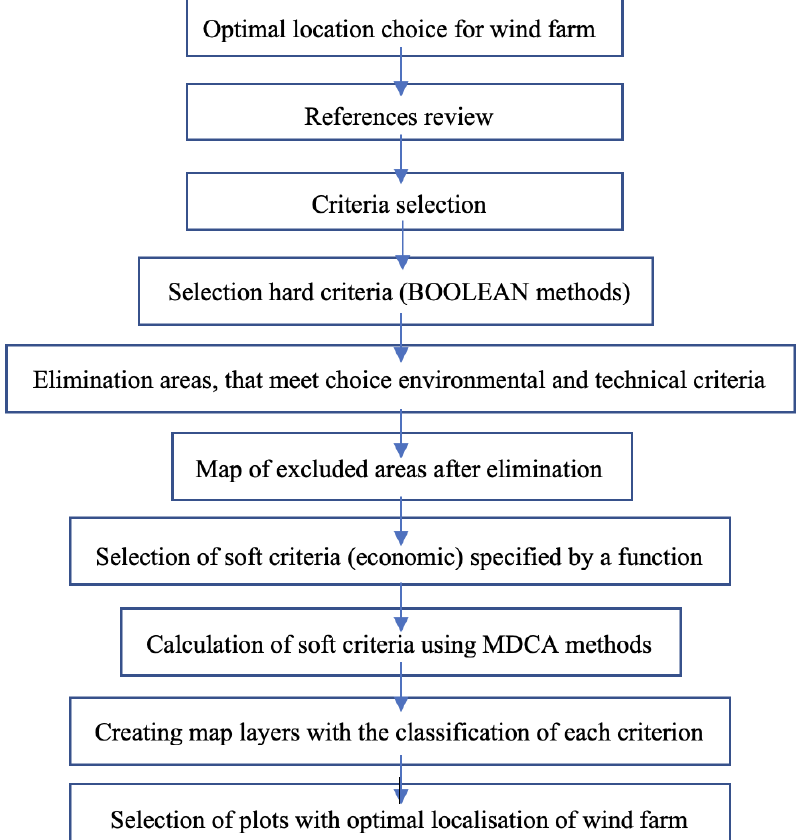
Figure 7. Flowchart of stages in selecting optimal localisation of wind farm.